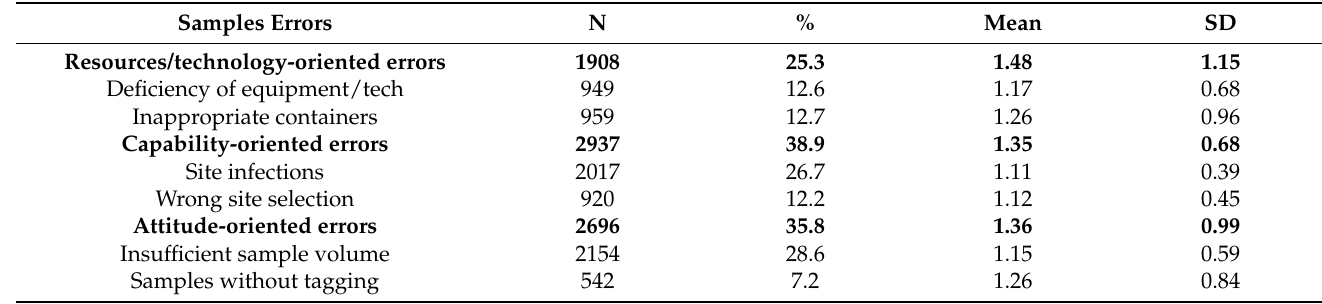
Table 2. Distribution of three types of sample errors and their